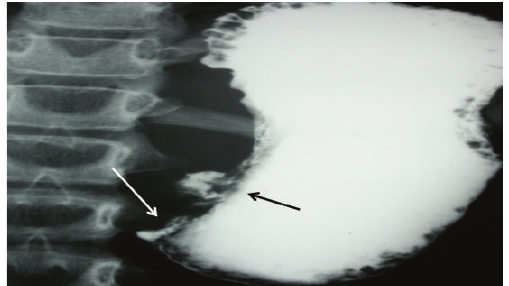
Figure 4: Endoscopic view of obstruction at pylorus (long arrow) and a clean bed of an ulcer at lesser curvature (short